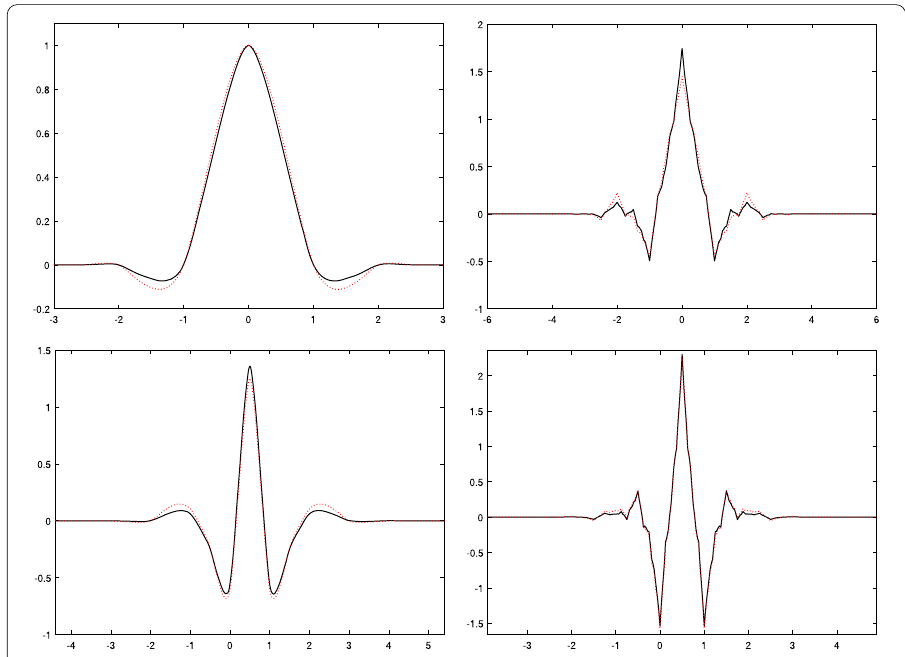
Figure 1 The refinable function with the symbol in (18), the dual refinable function and the corresponding wavelet functions at scale 0 with v 0 = 0 (dashed line) and v 0 = 1 (solid line). From left to right and top to bottom: φ 0 , ˜ φ 0 , ψ 0 and ˜ ψ